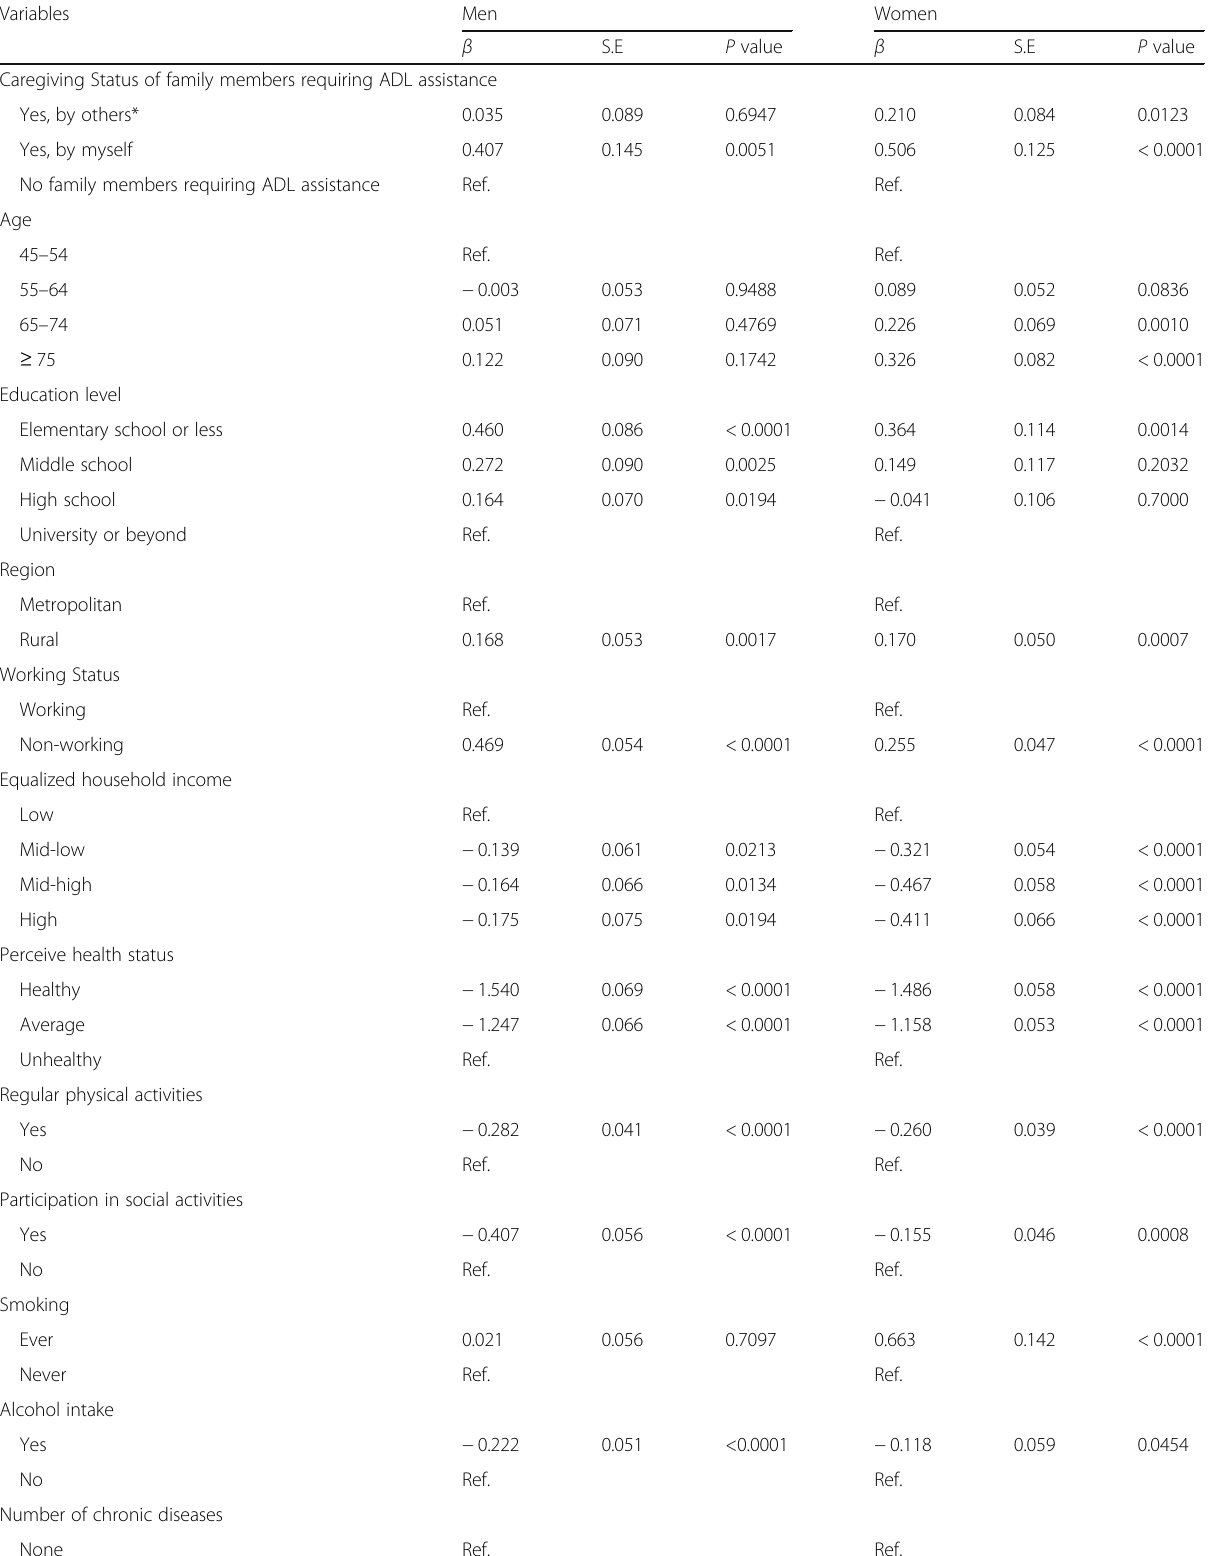
Table 2 Results of analysis of factors associated with CES-D 10